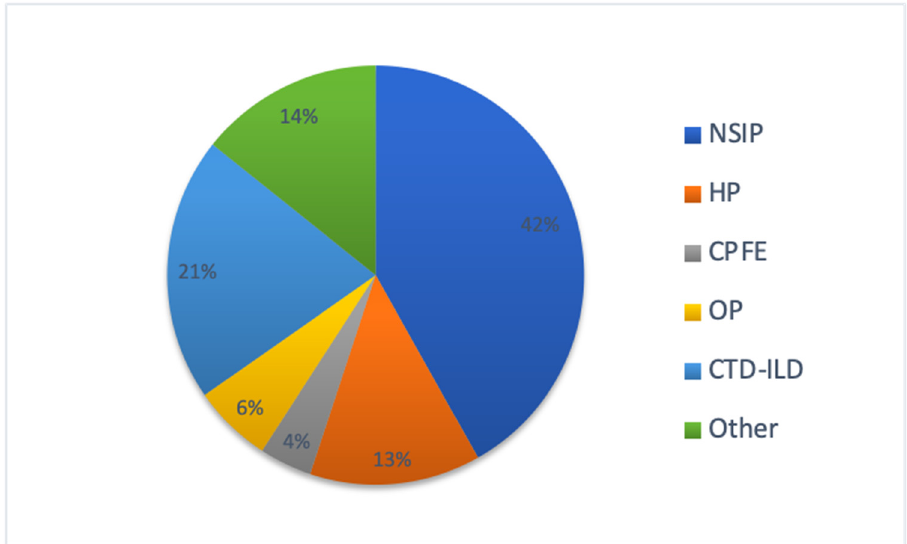
Figure 2. Distribution of different ILDs in the non-IPF group. NSIP: non-specific interstitial pneumonia; HP: hypersensitivity pneumonia; CPFE: combined pulmonary fibrosis and emphysema; OP: organizing pneumonia; CTD-ILD: connective-tissue-disease-related ILD. CTD-ILD included: Sjogren syndrome, mixed connectivitis, systemic sclerosis, rheumatoid arthritis, antisynthetase syndrome, p-ANCA vasculitis. Others included: undifferentiated ILD, AIP, LIP, AFOP, and eosinophilic pneumonia. Table 1. Baseline characteristics, clinical presentation, and blood exams at hospital Compared with non-IPF patients, those with IPF were predominantly males (81% vs. 59%— p 0.0019) and former or ex-smokers (82% vs. 53%— p 0.004). The age at diagnosis